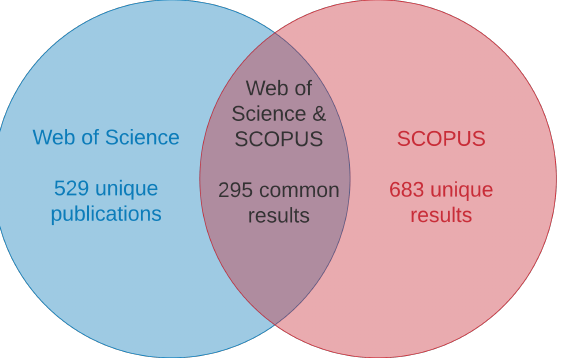
Figure 1. Venn diagram illustrating two distinct sets of results extracted from the Web of Science and SCOPUS